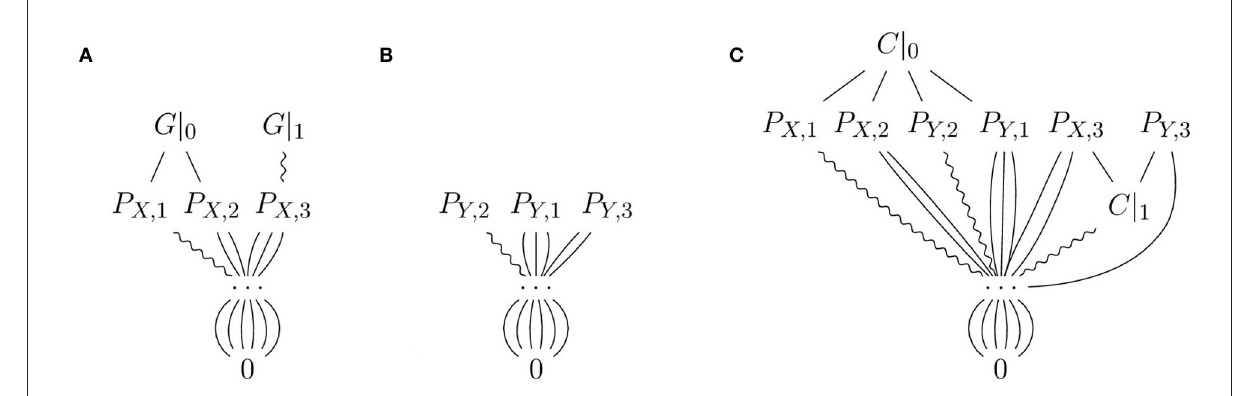
FIGURE12 The three parts (A–C) of the semantic structure from Figure 11 after m 6